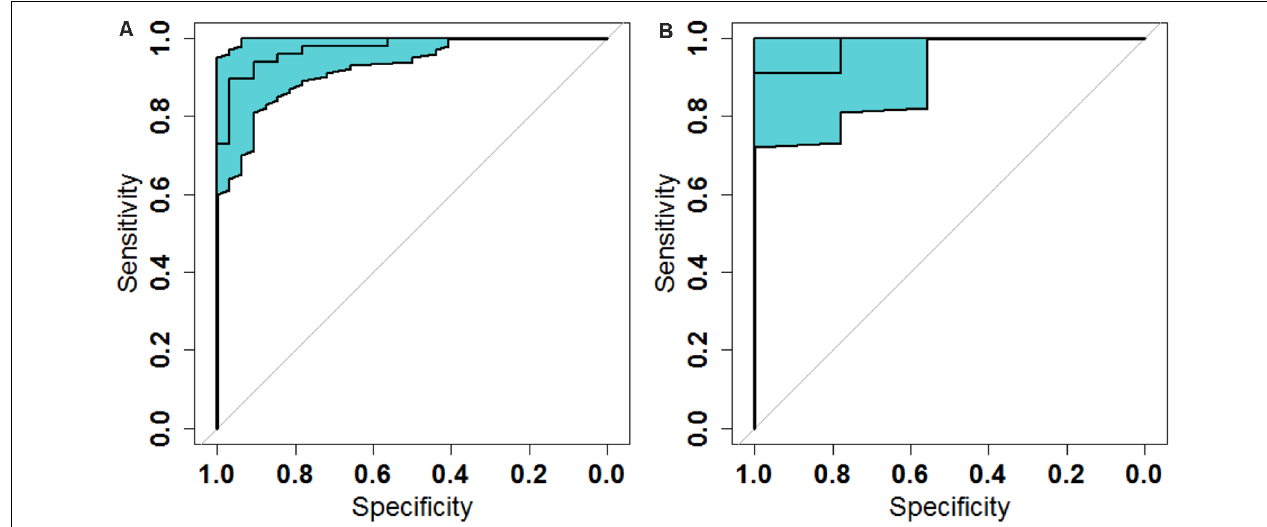
FIGURE 6 | Receiver operating characteristic (ROC) analysis of the radiomic signature scores in the primary (A) and validation (B)